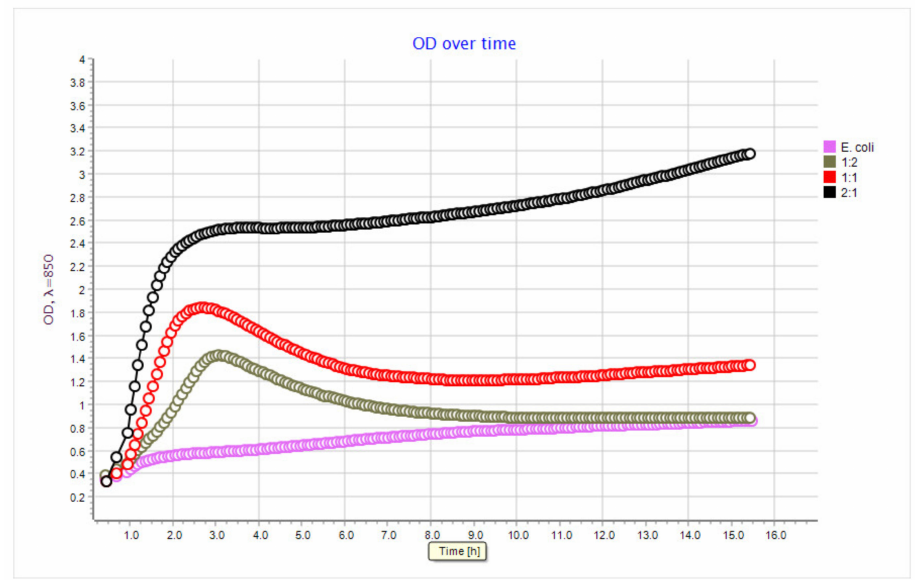
Figure 2. The influence of mixtures of S. baicalensis and Glycyrrhiza L. extracts on the growth of E . coli